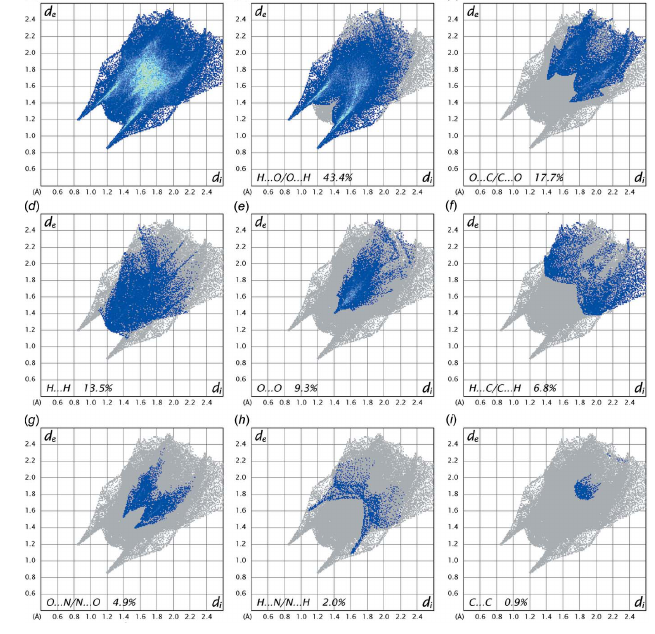
Figure 4 Full two-dimensional fingerprint plots for the title compound, showing all interactions ( a ), and delineated into ( b ) H (cid:2)(cid:2)(cid:2) O/O (cid:2)(cid:2)(cid:2) H, ( c ) O (cid:2)(cid:2)(cid:2) C/C (cid:2)(cid:2)(cid:2) O, ( d ) H (cid:2)(cid:2)(cid:2) H, ( e ) O (cid:2)(cid:2)(cid:2) O, ( f ) H (cid:2)(cid:2)(cid:2) C/C (cid:2)(cid:2)(cid:2) H, ( g ) O (cid:2)(cid:2)(cid:2) N/N (cid:2)(cid:2)(cid:2) O, ( h ) H (cid:2)(cid:2)(cid:2) N/ N (cid:2)(cid:2)(cid:2) H and ( i ) C (cid:2)(cid:2)(cid:2) C interactions. The d i and d e values are the closest internal and external distances (in A˚ ) from a given point on the Hirshfeld surface.